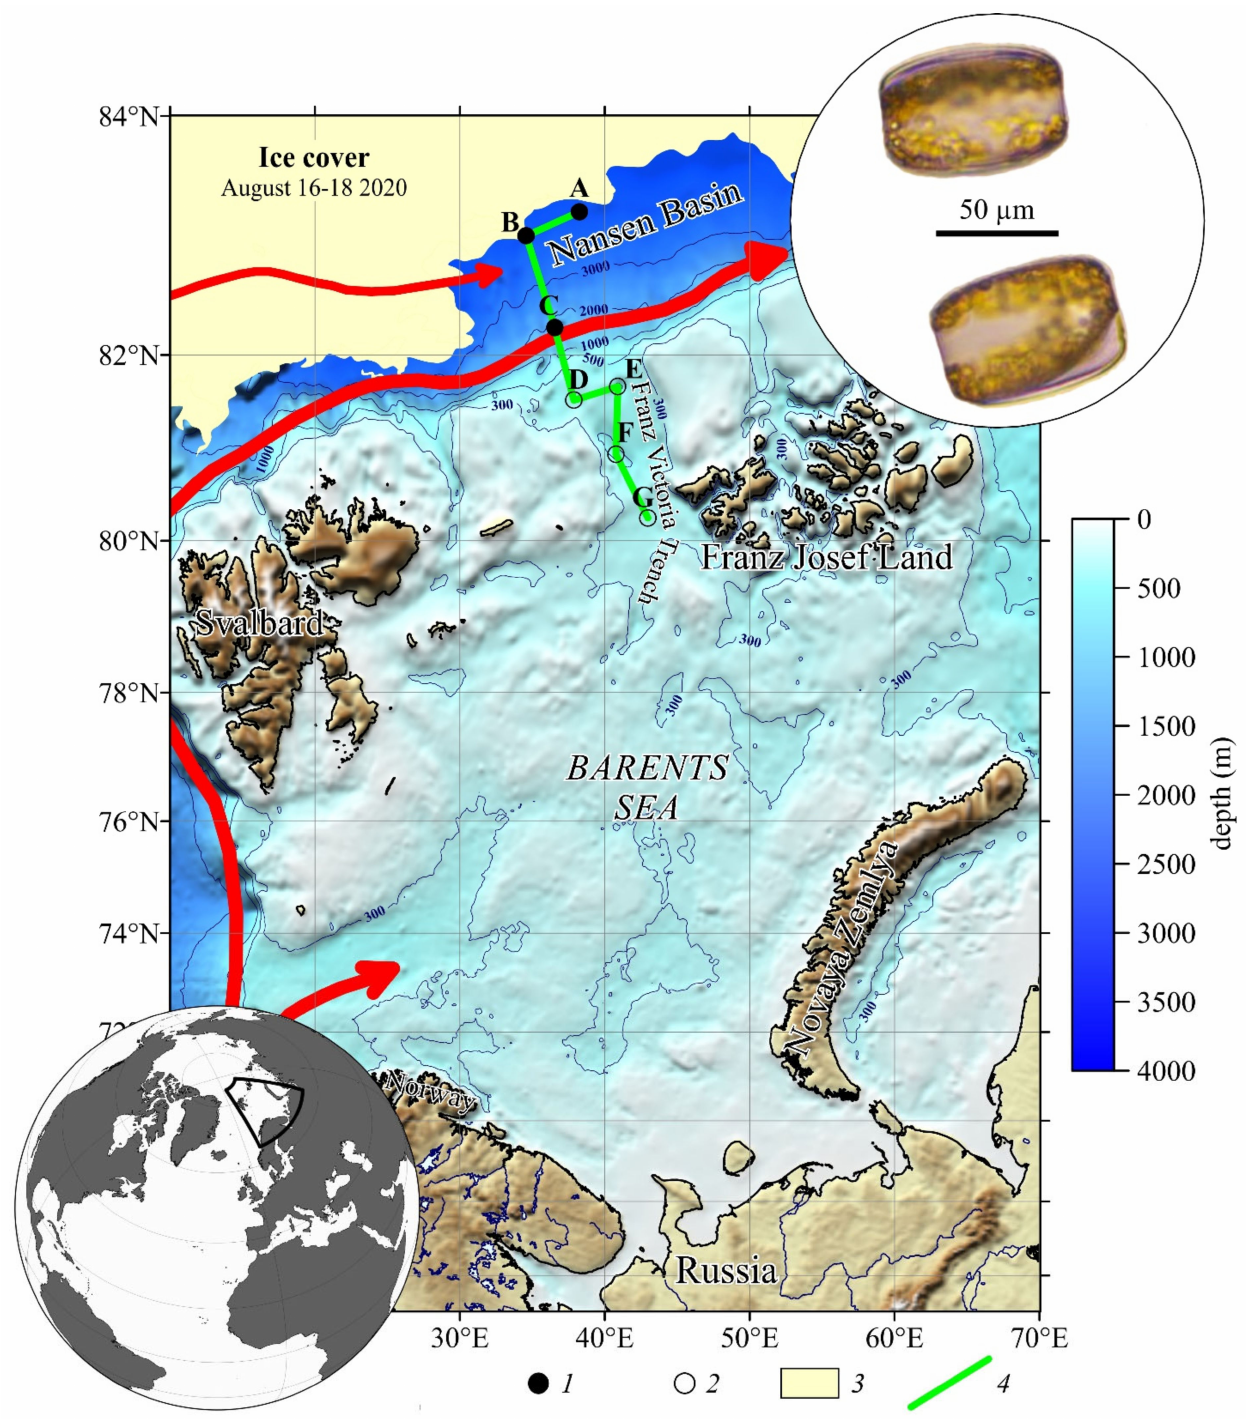
Figure 1. The map of sampling stations in the Nansen Basin and the Barents Sea in August 2020: (1) deep water stations; (2) shelf stations; (3) ice edge position; (4) transect position. Based on